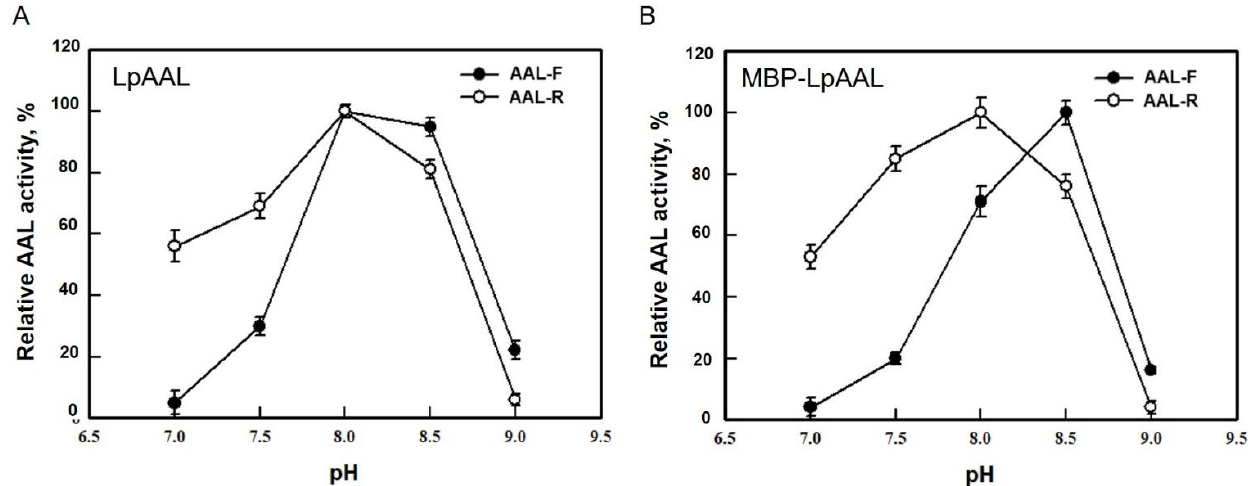
Figure 4. Optimum reaction pH of AAL-F and AAL-R activities of LpAAL ( A ) and MBP-LpAAL ( B ) enzymes. Activities were measured under standard assay conditions in a range of pH from 7.0 to 9.0. All experiments were performed in triplicate and expressed as average ± standard deviation (S.D., error bars). The average of maximum activity was normalized as 100%.